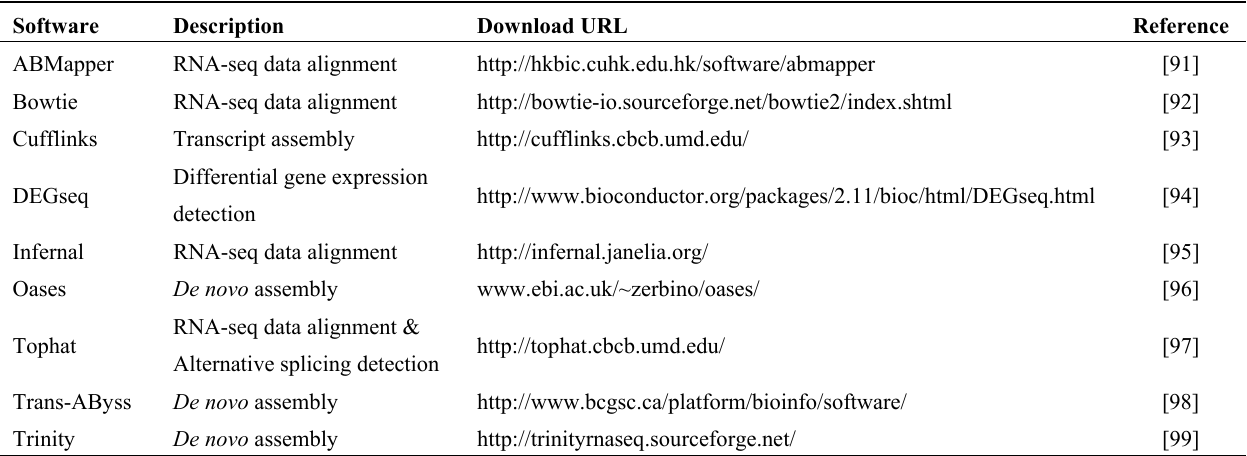
Table 4. Widely used bioinformatics tools for the analysis of transcriptome